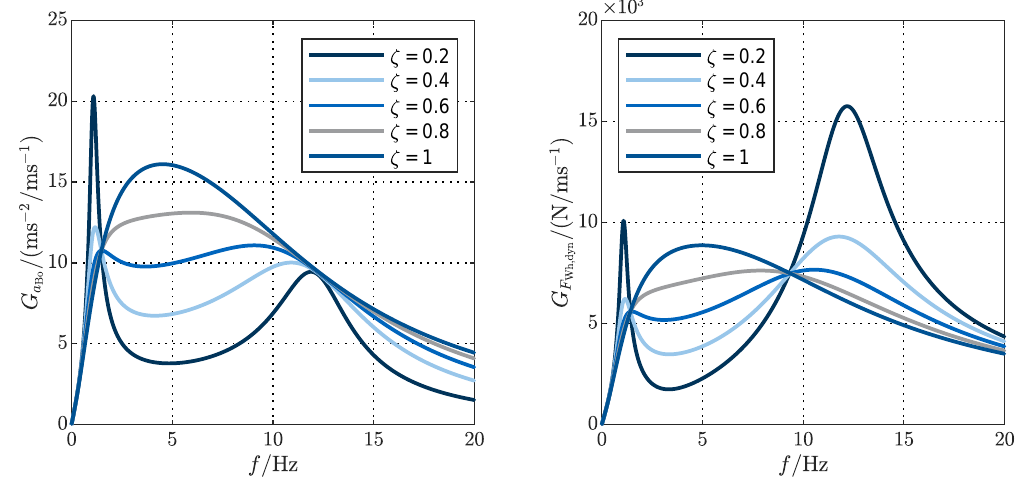
Figure 2. Frequency response of a quarter vehicle model to road velocity input, for varying suspension damping ratios ζ . Body acceleration gain G a the ( right